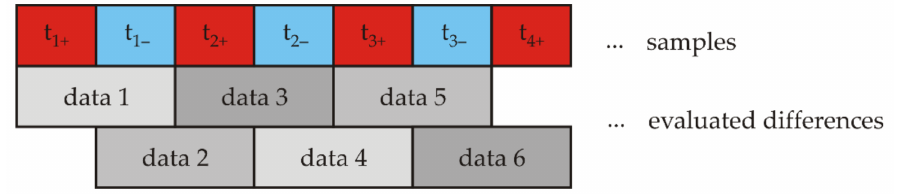
Figure 7. Interleaving of samples.